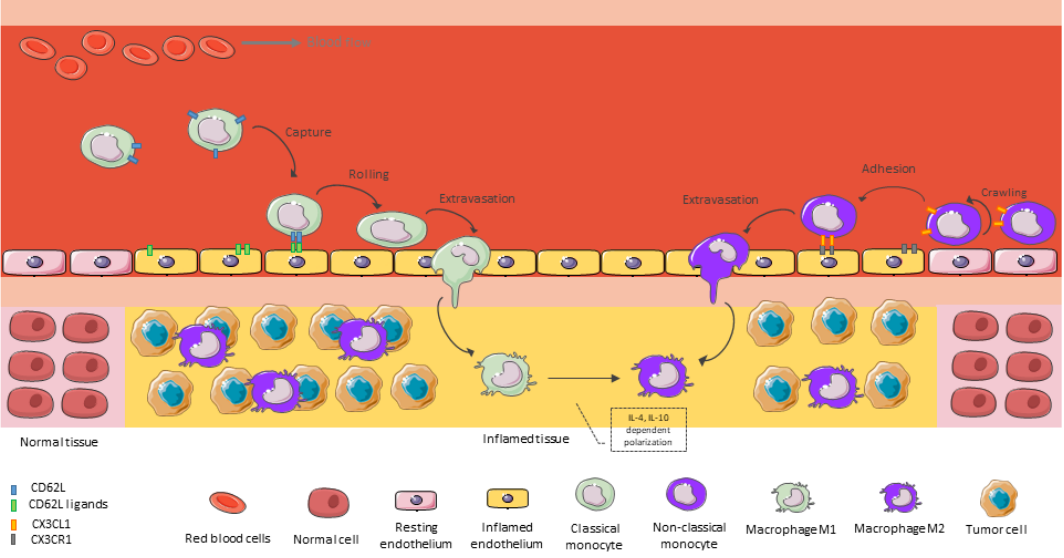
Figure 2. BMDM recruitment into inflamed brain tissue. An activated endothelium allows the recruitment of cells from the bloodstream through a well-orchestrated and coordinated mechanism.